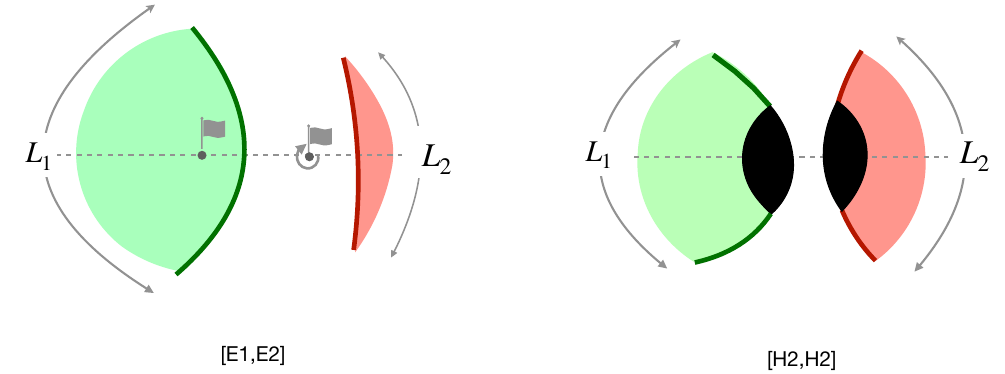
Figure 5 . Schematic drawing of a low-temperature and a high-temperature solution, corresponding to pairs of type [E1,E2] and [H2,H2]. The broken line is the axis of reflection symmetry. The blueshift parameter | σ | decreases monotonically until the string reaches either the turning point or the black-hole